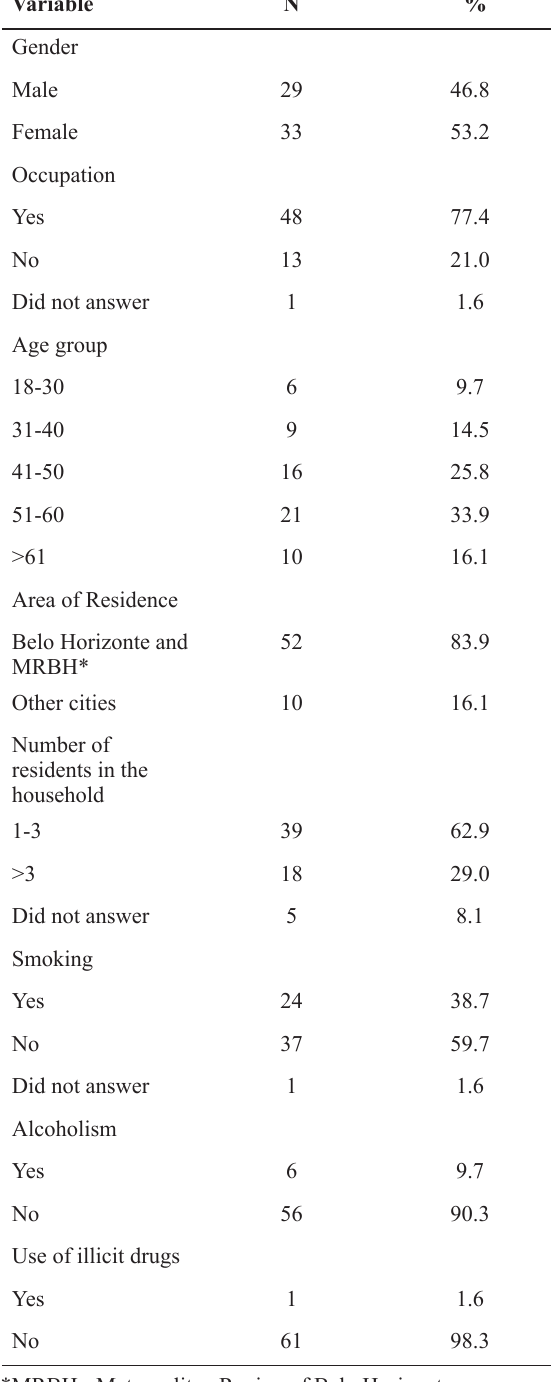
Sociodemographic and behavioral characteristics of tuberculosis patients treated at the tuberculosis secondary referral outpatient clinic, Belo Horizonte, from August 2009 to July 2012